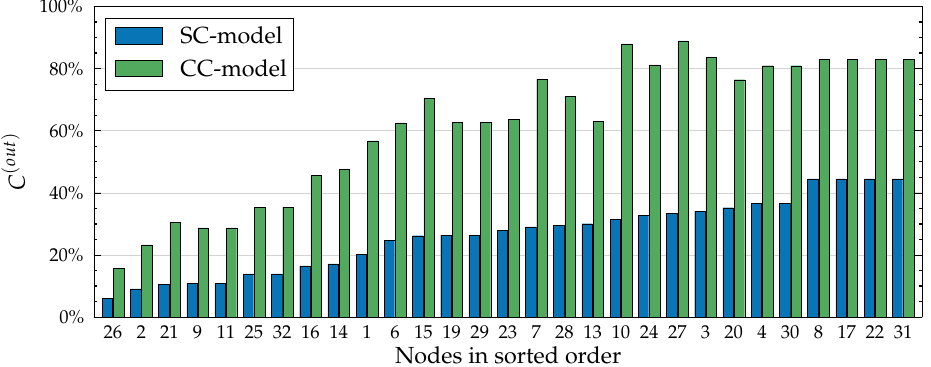
Figure 4. Comparison of SC and CC models using out-centrality values calculated in the Dutch Student network (see Figure 6) with L max → ∞ , λ = 1, T → ∞ , and w ( u , v ) = 0.5 for all ( u , v ) ∈ E . The out-centrality values are normalised and expressed as a percentage of all nodes. C ( s ) ( out ) is defined for all s ∈ V in Equation